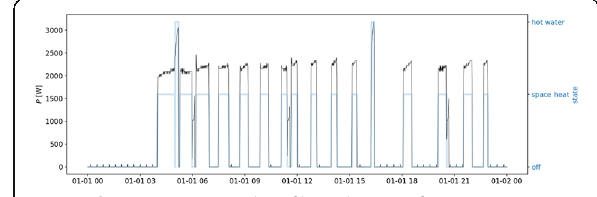
Fig. 1 (abstract P10). Load profile and states of an air source HP (PLZ92242) from WP Monitor data